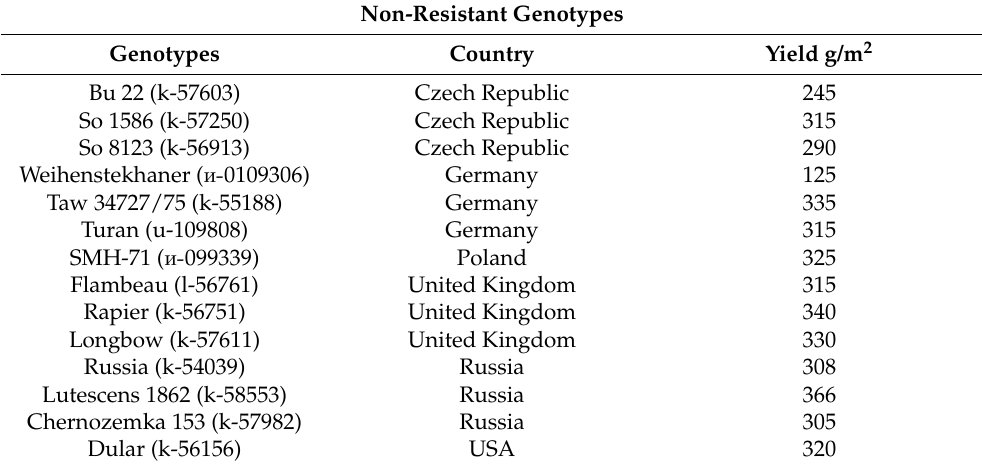
Table 2. Yield of the non -resistant genotypes (1988–1989).